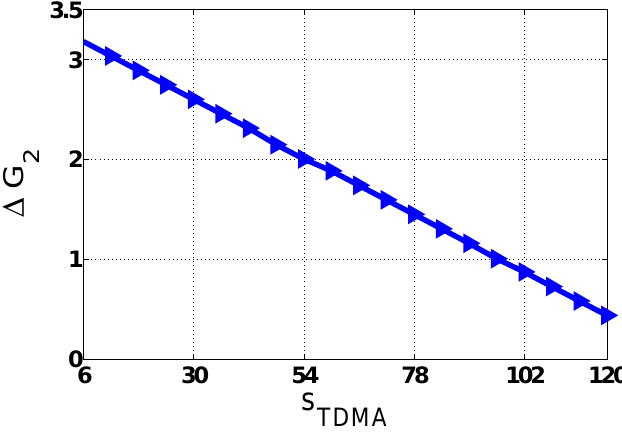
Figure 9. The difference of G 2 at N max = 100 and N min =